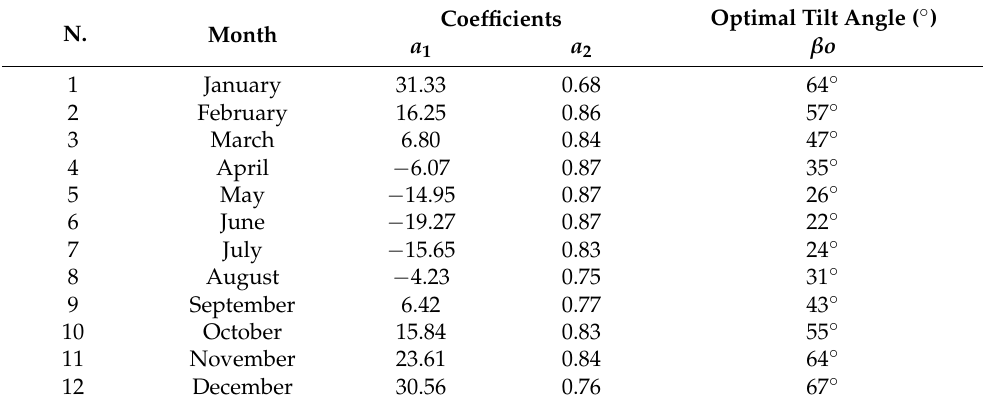
Coefficients Optimal Tilt Angle ( ◦ )